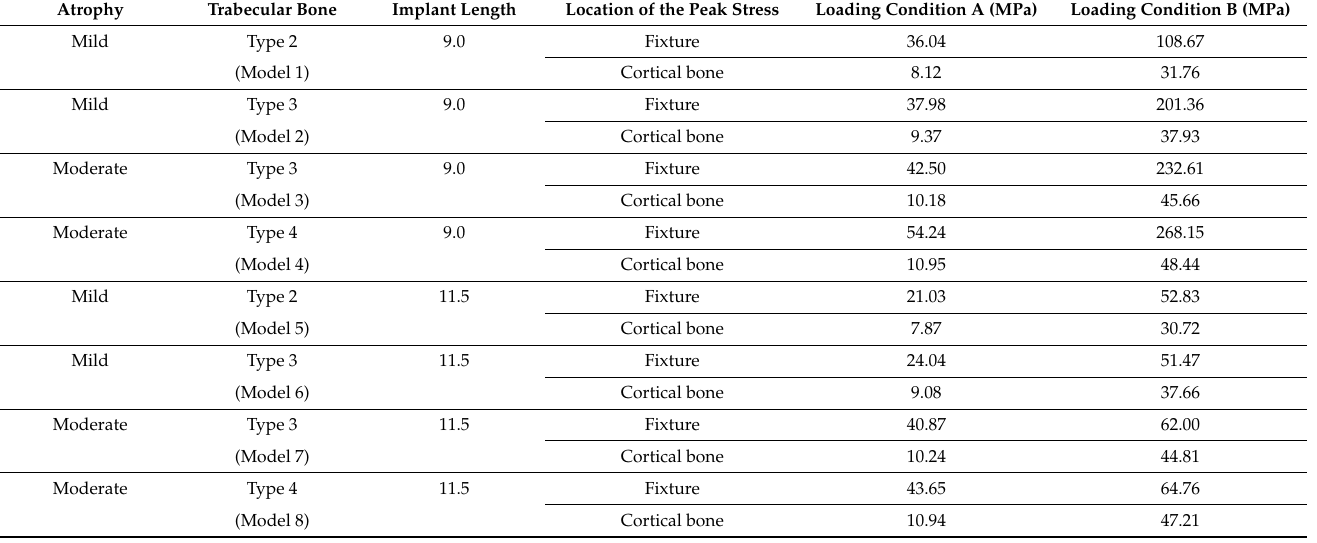
Table 2. The peak values of von Mises stresses located on fixture of the implant as well as surrounding cortical bone around the implant at different loading